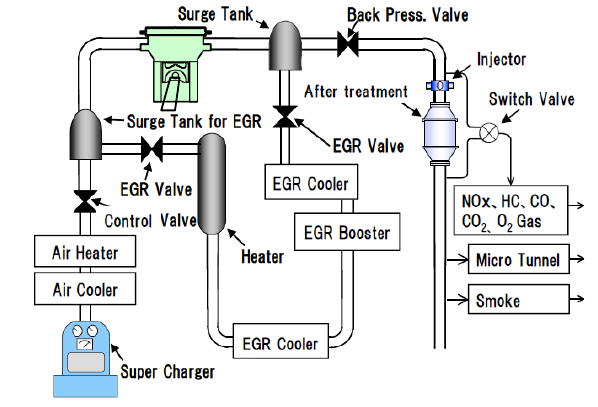
Fig. 7. Schema of experimental apparatus